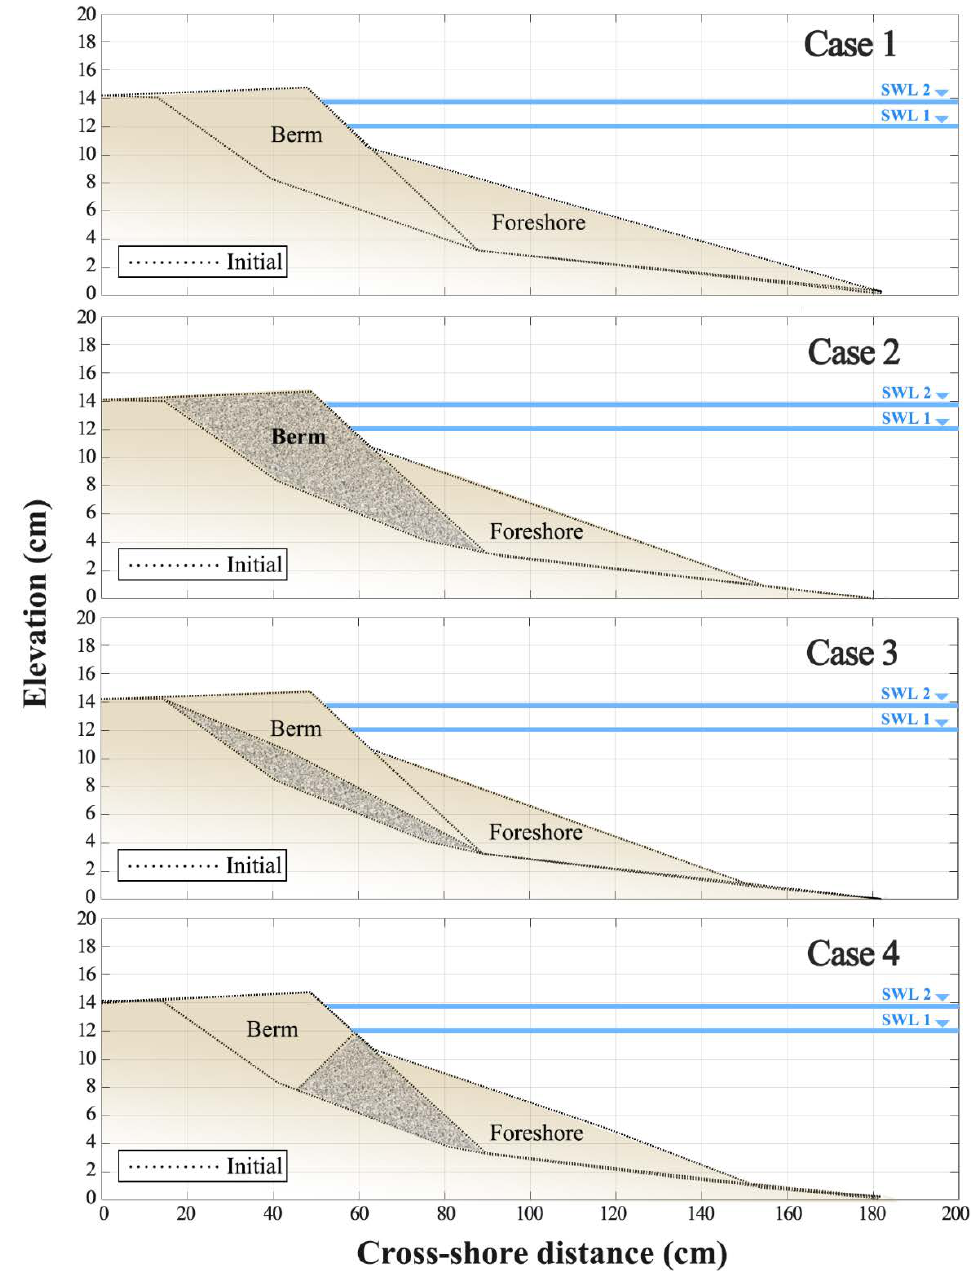
Figure 5. Initial profiles of test cases 1, 2, 3, and 4.